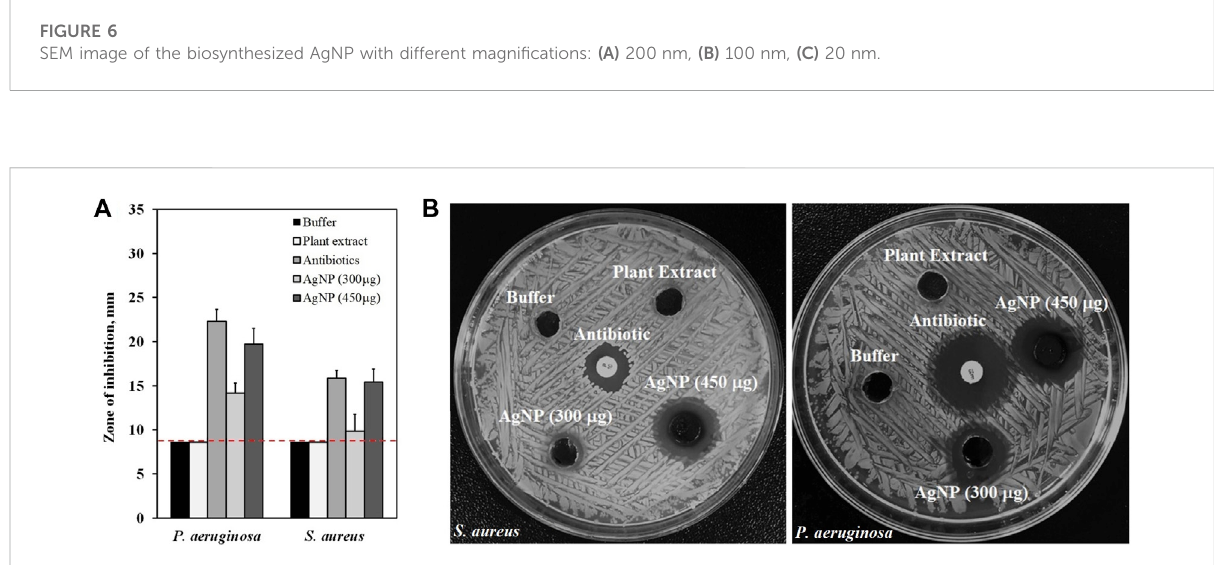
FIGURE 7 AntibacterialactivityofthesynthesizedAgNPagainst S.aureus and P.aeruginosa : (A) diameteroftheinhibitionzonewithstandarddeviation, (B) Images of agar plates loaded with AgNP (300 and 450 μ g/ml), Antibiotics (erythromycin and penicillin G), Plant Extract and HEPES buffer. Dotted red lines represent level of no